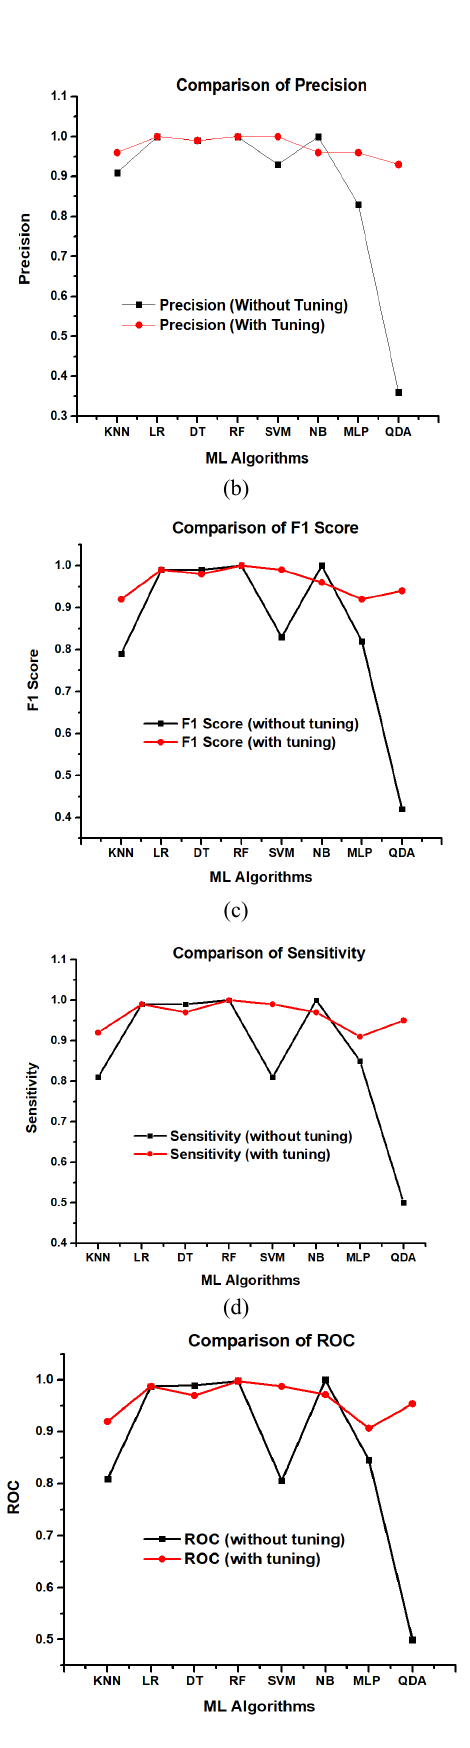
Figure 3. Comparison of (a) accuracy (b) precision (c) F1 score (d) sensitivity and (e) ROC of different